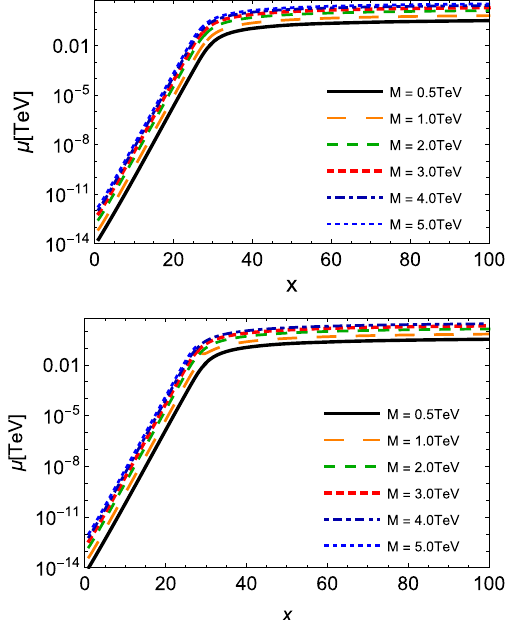
Fig. 8 The chemical potential for monopoles as a function of x = M / T , according to Eqs. (22) and (13), taking different values of the monopole mass M . Plots in the top and bottom panels: cases of spin 0 and 1 / 2,